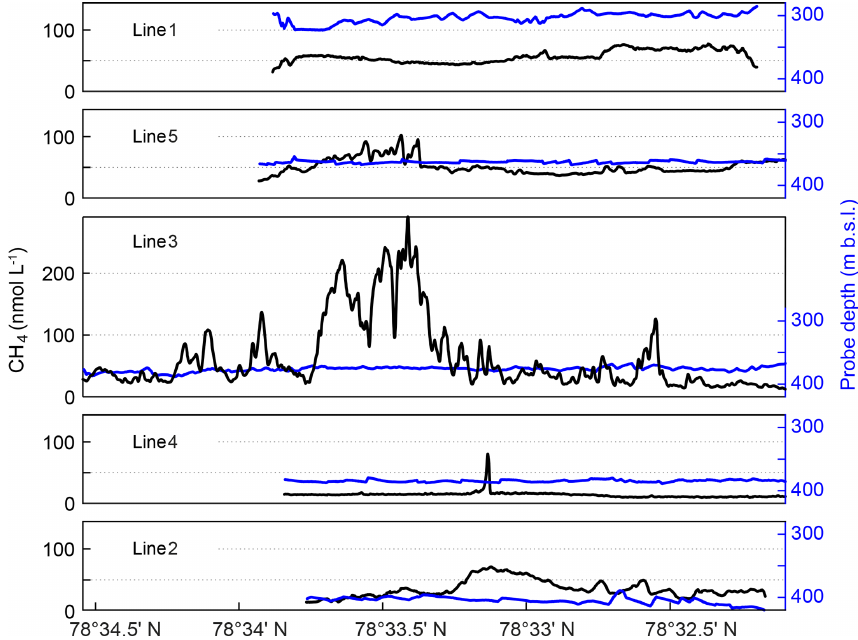
Figure 3. MILS measurements along the five lines ∼ 15m from the seafloor. Panels show data acquired along lines 1–5, shown in order of proximity to the shore, with line 1 closest to the shore and line 2 furthest offshore. See Fig. 1a for line locations. Black lines show CH 4 concentrations, blue lines show the probe